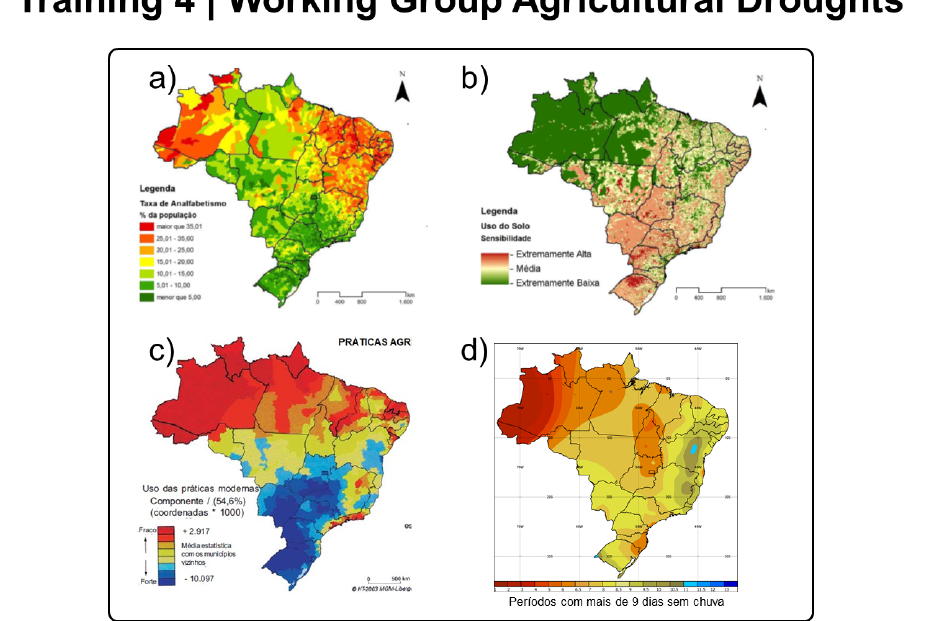
Figure A20. Package of maps used in the fourth training for mapping climate risk associated with agricultural droughts. The maps illustrate